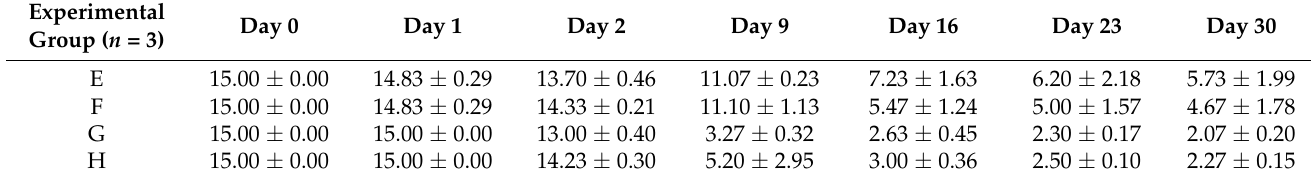
Table 3. Results of the contraction assay with respect to the length of tendon-like constructs (TLC). The results are shown as mean value with the corresponding standard deviation in cm.